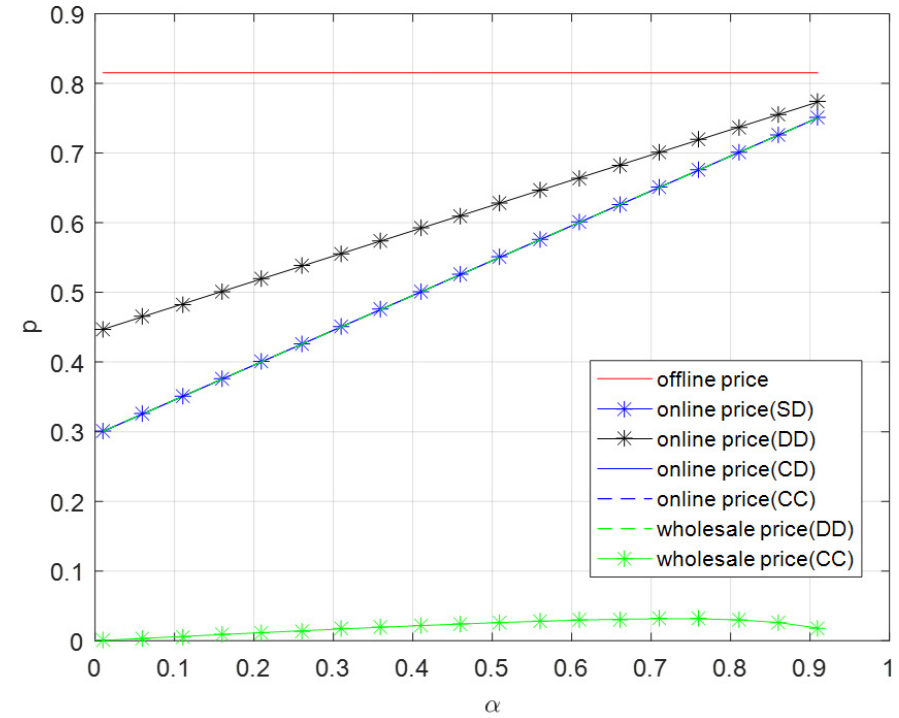
Figure 5. Optimal price versus α